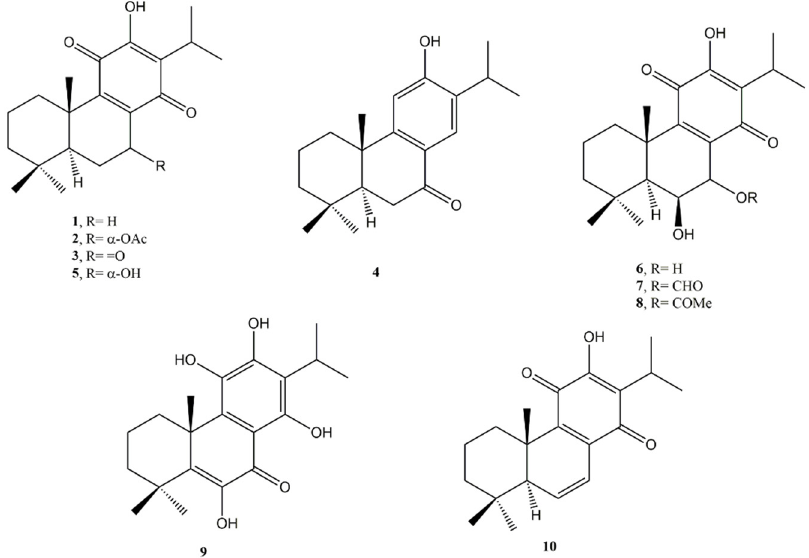
Figure 1. Bioactive abietane diterpenes: Royleanone ( 1 ); 7 α -acetoxyroyleanone ( 2 ); 7-ketoroyleanone ( 3 ); Sugiol ( 4 ); Horminone ( 5 ); 7 α ,6 β -dihydroxyroyleanone ( 6 ); 7 α -formyloxy-6 β -hydroxyroyleanone ( 7 ); 7 α -acetoxy-6 β -hydroxyroyleanone ( 8 ); Coleon U ( 9 ); 6,7-dehydroroyleanone ( 10